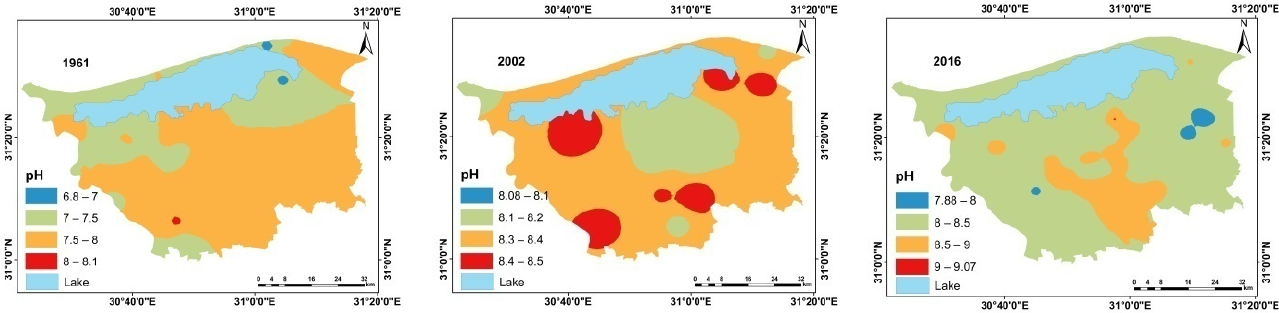
Figure 9. pH prediction maps in 1961, 2002, and 2016.